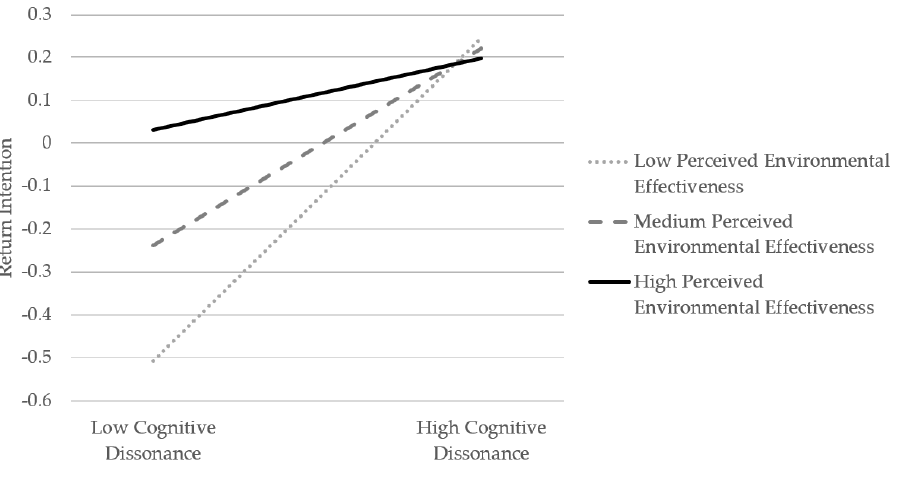
Figure 3. The analysis of moderating effect.